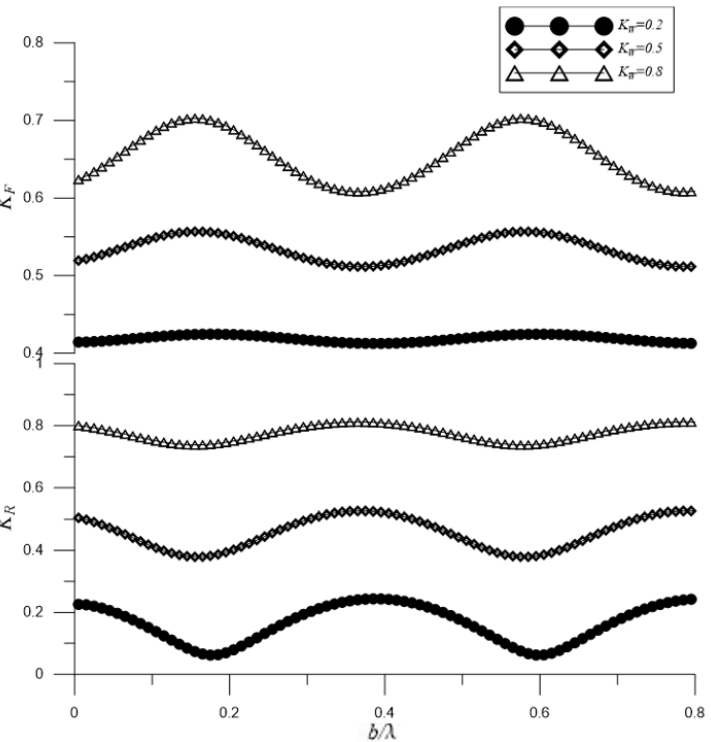
Figure 13. Effects of the wall partially reflecting factors K w on the dimensionless wave force and reflection coefficient with oblique incidence of γ = 30 ◦ .